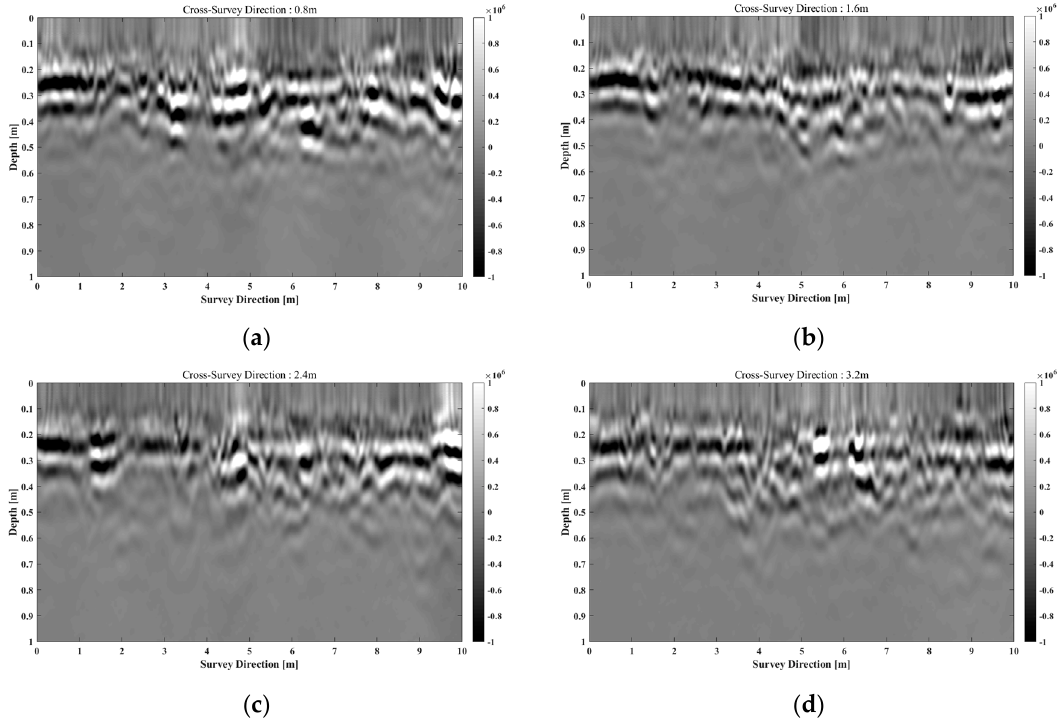
Figure 7. Migrated vertical profiles along the survey direction. ( a ) Migrated profile at 0.8 m cross-survey direction; ( b ) migrated profile at 1.6 m cross-survey direction; ( c ) migrated profile at 2.4 m cross-survey direction; ( d ) migrated profile at 3.2 m cross-survey direction.